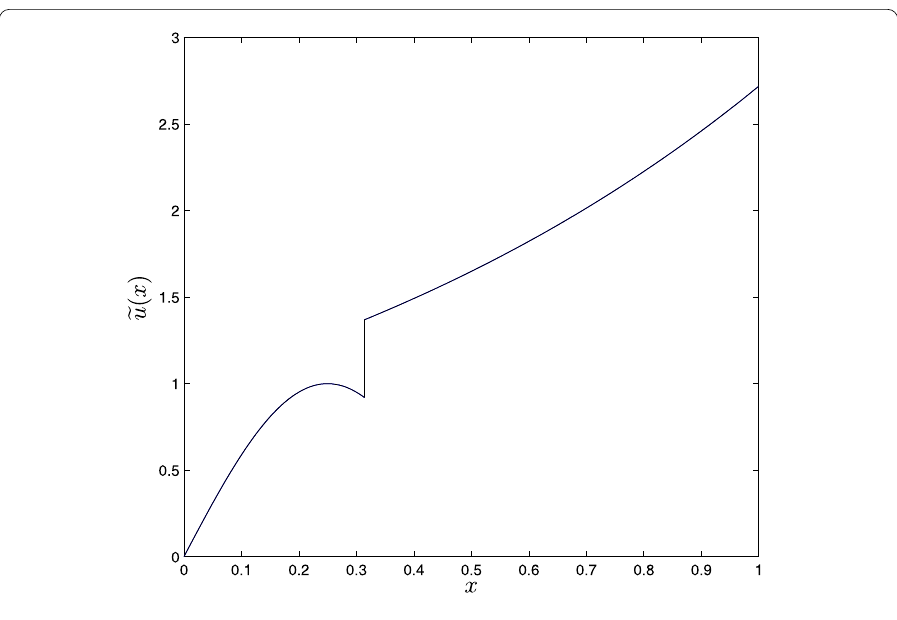
Figure 1 The exact solution of Example 1